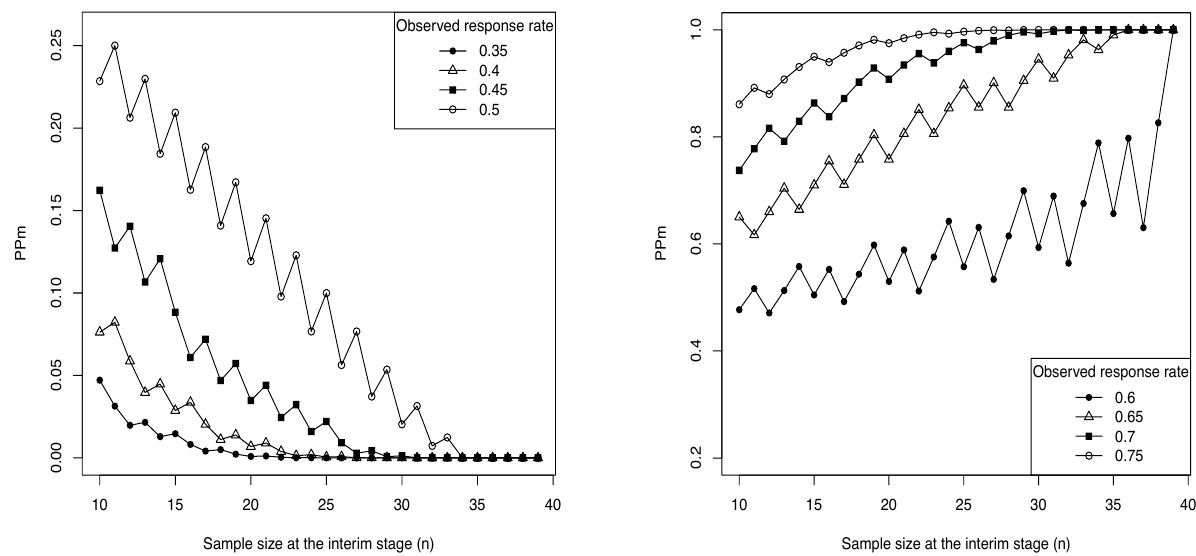
Figure 2. Behavior of PPm as a function of n for different values of the response rate assumed to be observed at the interim stage, when N = 40, N min = 10, δ = 0.1, π ( p S ) = beta ( p S ;63,94 ) , π ( p E ) = beta ( p E ;1.4,1.6 ) and θ T = 0.8.